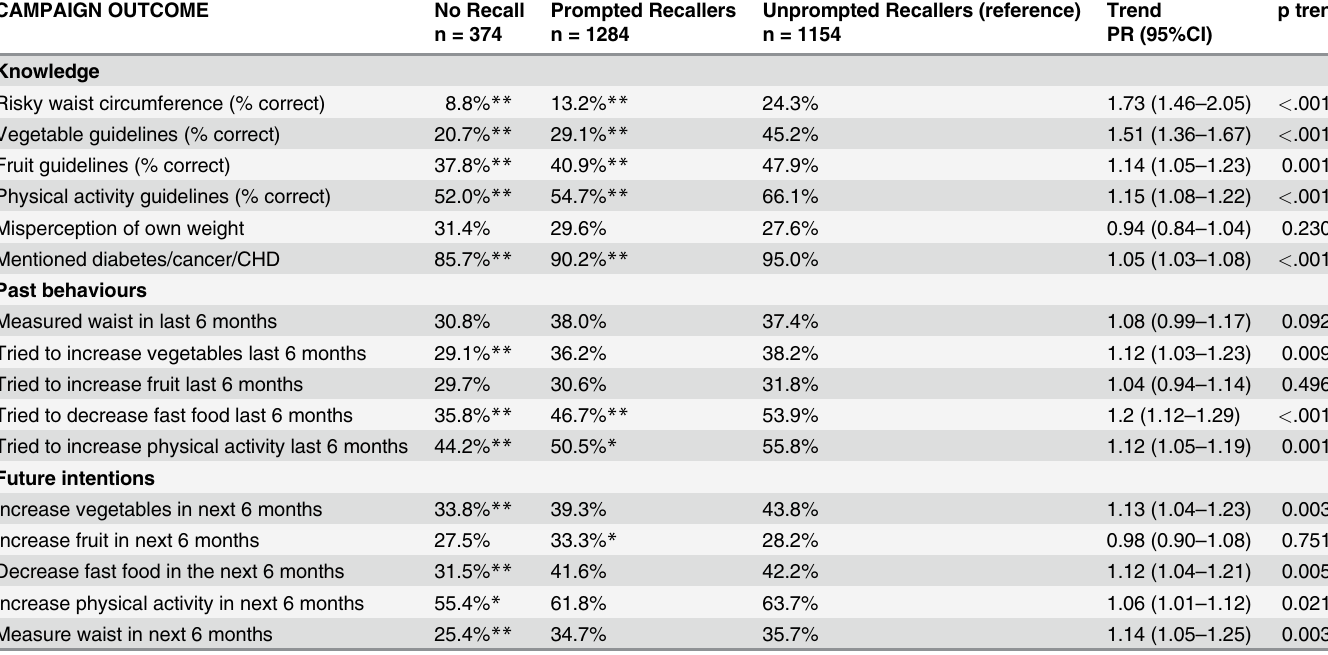
Table 3. Measure-Up campaign-related knowledge, behaviours, and intentions for each campaign recall group, with tests for trend. CAMPAIGN